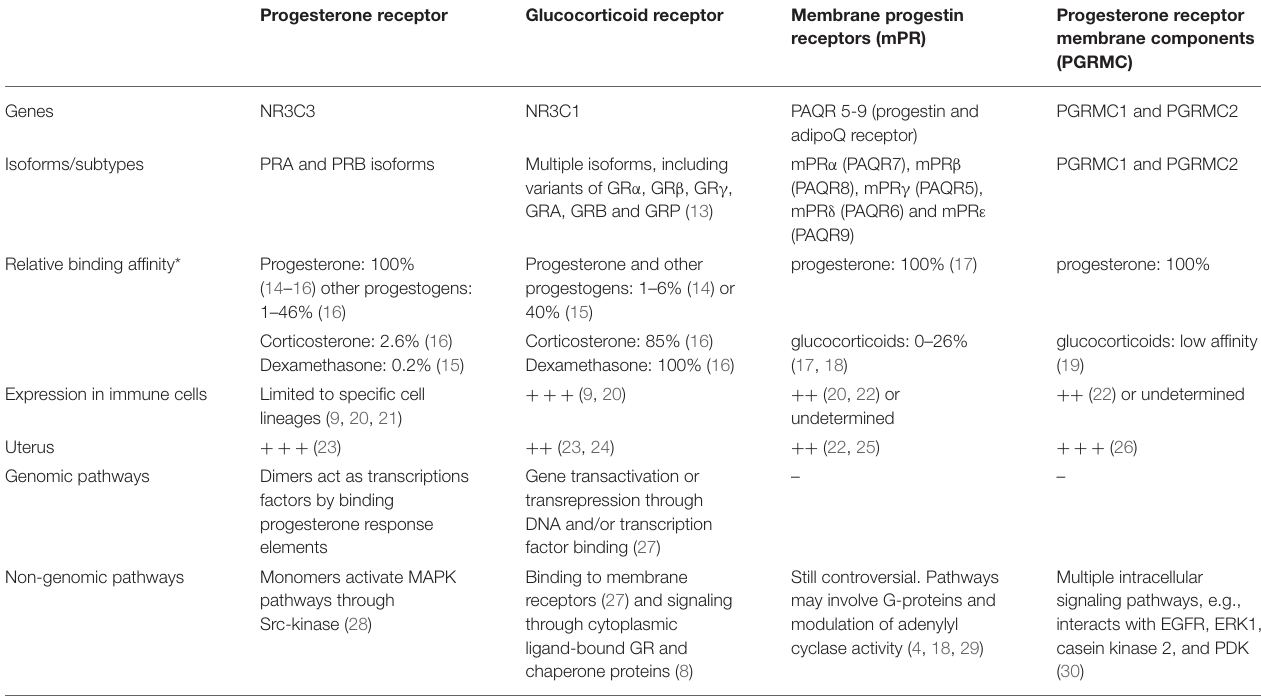
TABLE 1 | Comparison between general features of the progesterone and glucocorticoid